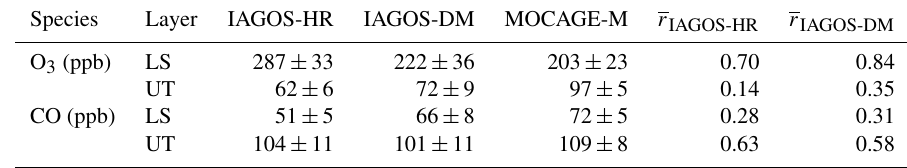
Table 3. Cross-regional averages derived from the seasonal cycles. Yearly mean values and interannual variabilities are shown for IAGOS- HR, IAGOS-DM and MOCAGE-M, along with the correlation coefficient between MOCAGE-M and the two IAGOS versions.